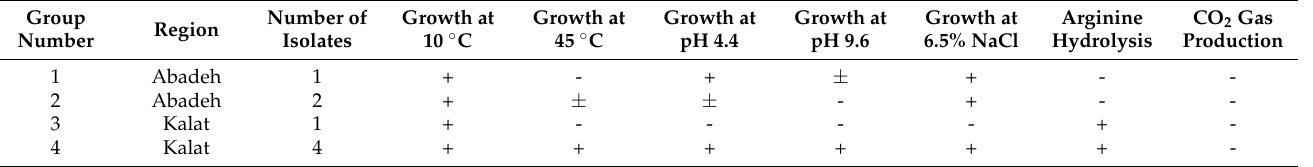
Table 1. Characteristics of LAB isolates of Abadeh (Fars) and Kalat (Razavi Khorasan) kashk samples.